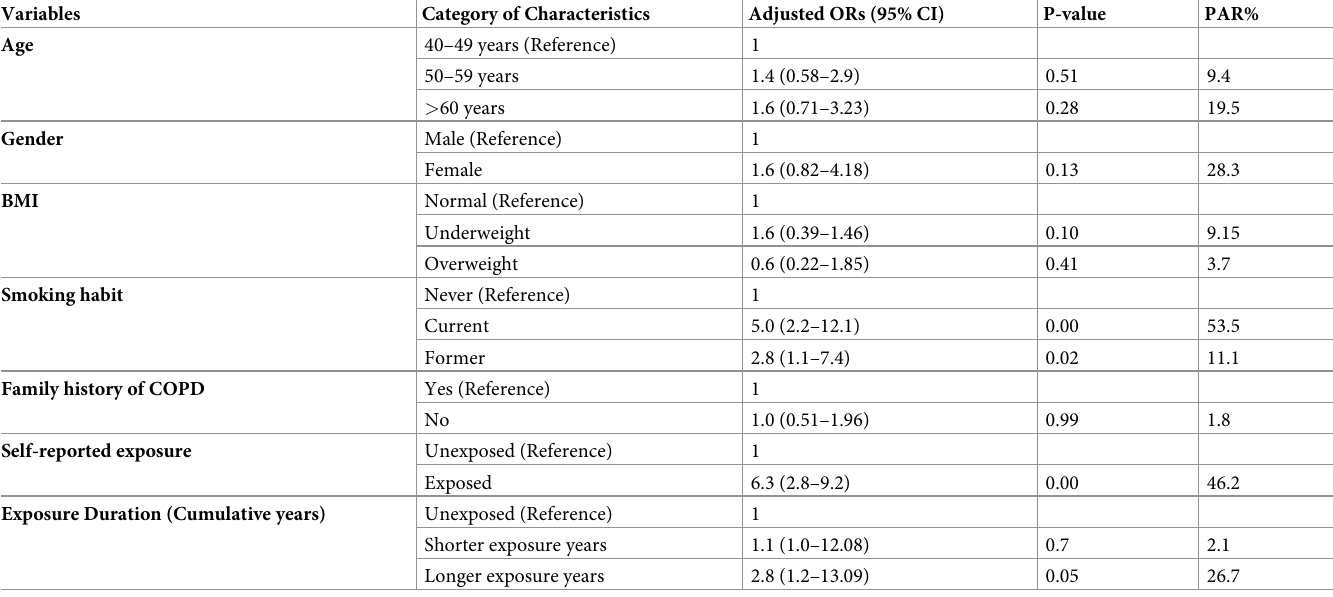
Table 7. Binary logistic regression analysis to associate COPD with other independent variables and